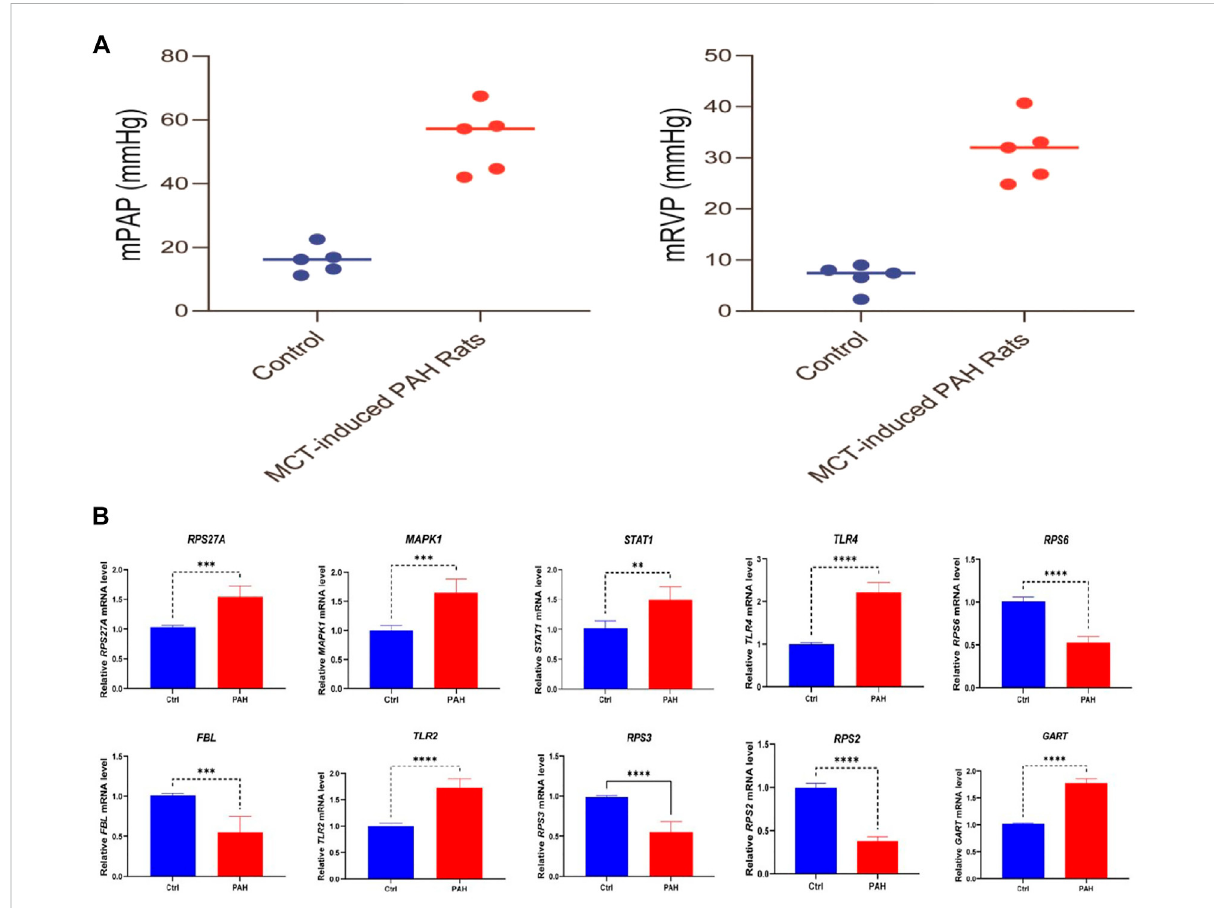
FIGURE 11 Validation of hub genes expression level in the lung tissue between rats with PAH ( n = 5) and normal ( n = 5). (A) The result of hemodynamic indicators between the control and PAH groups. (B) The results show that 5 screened hub genes ( MAPK1, STAT1, TLR4, TLR2, GART ) are signi fi cantly highly expressed in PAH rats, and 4 screened hub genes ( RPS6, FBL, RPS3, and RPS2 ) are substantially lower expressed in rats with PAH. pp p < 0.01; *** p < 0.001; pppp p <